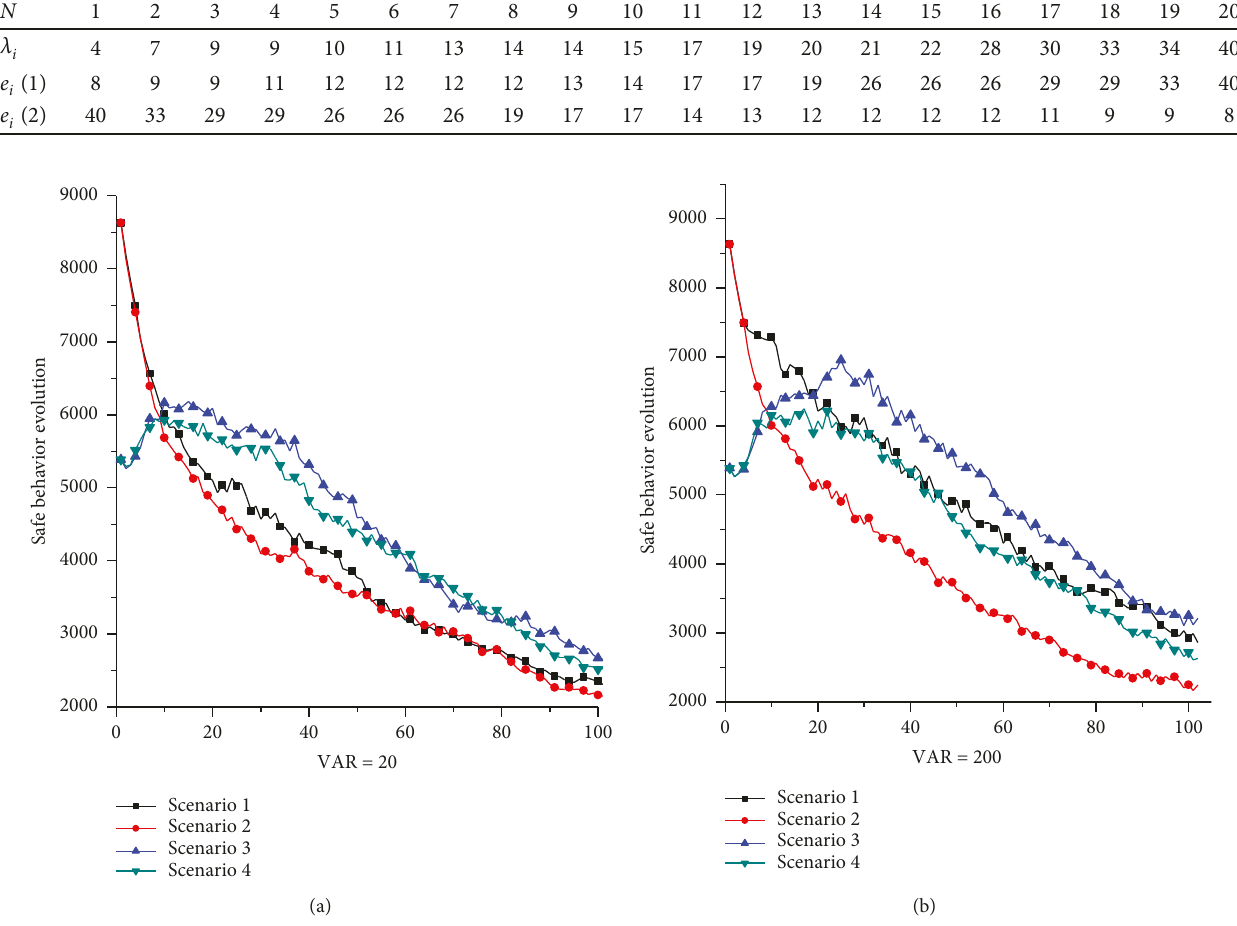
Figure 3: Evolution of safety behavior of construction team members under di ff erent